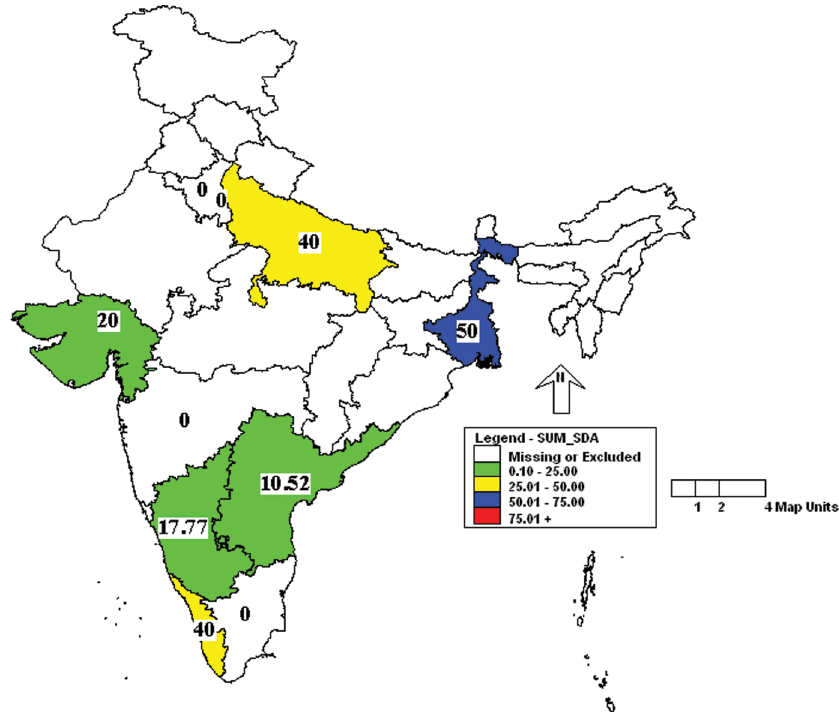
Fig 5. Incidence of Sialodacryoadenitis virus (SDAV) in different states of India. Green — 00.00 to 25.00%; Yellow — 25.01 to 50.00%; Blue — 50.01 to 75.00%.